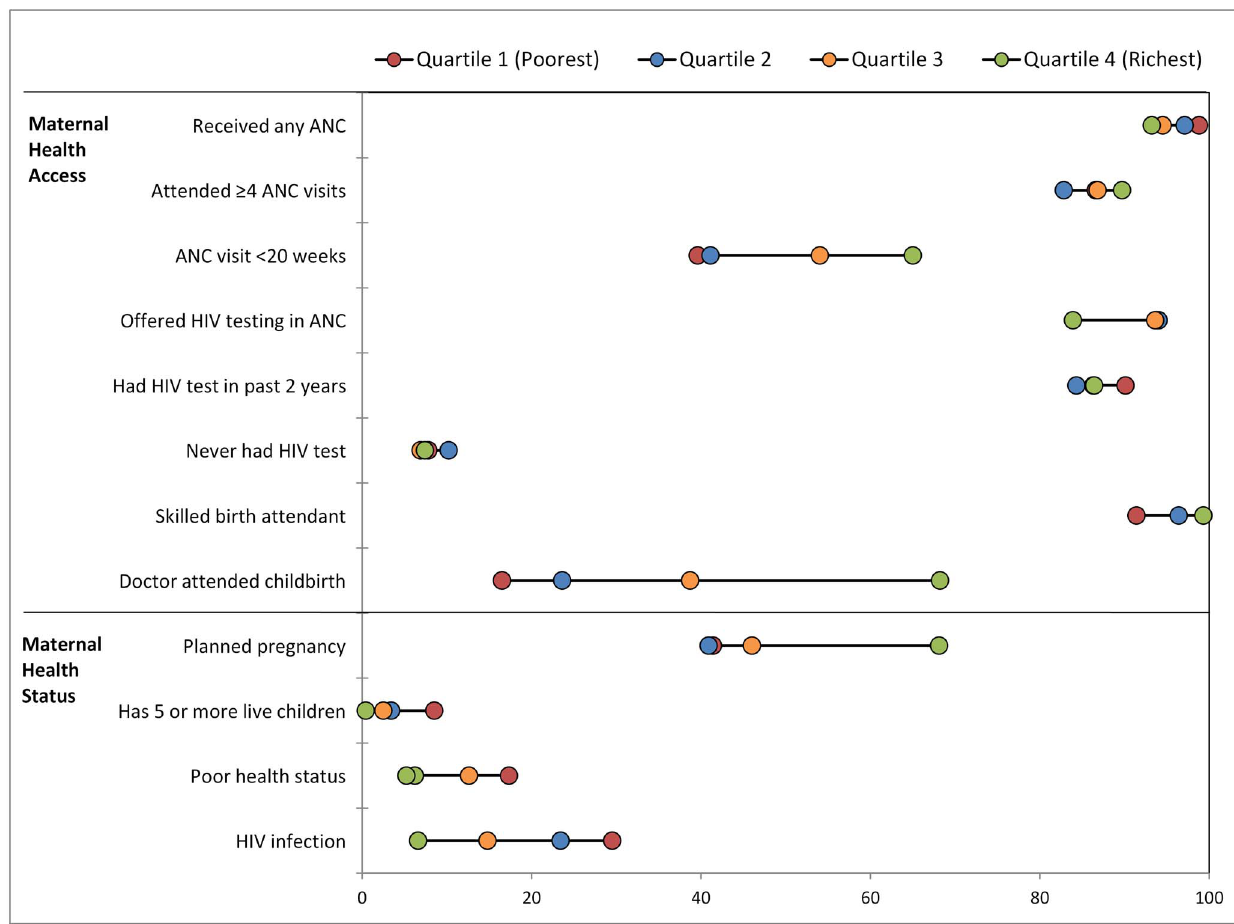
Figure 1. Differentials in coverage of maternal health services and in maternal health status in South Africa. Differentials in coverage of maternal health services and in maternal health status across socio- economic quartiles in South Africa.